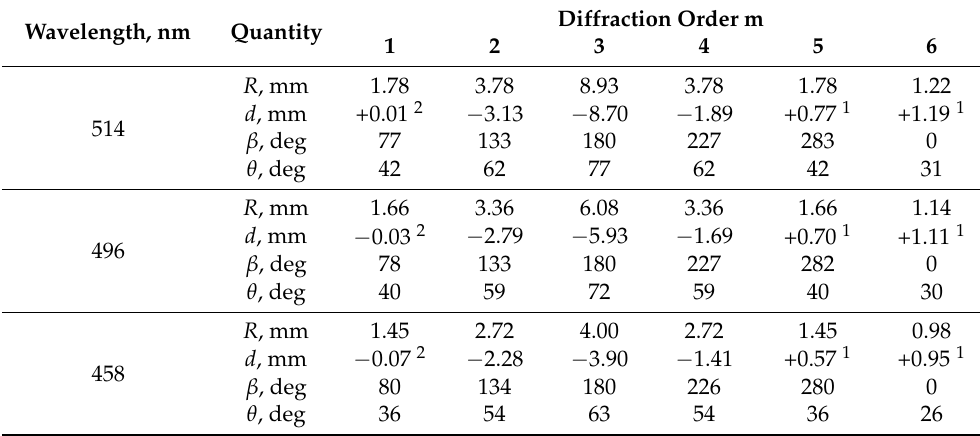
Table 2. Oblique incidence: theoretical expectation of the geometrical parameters of the heat sources produced by the absorption of the diffracted